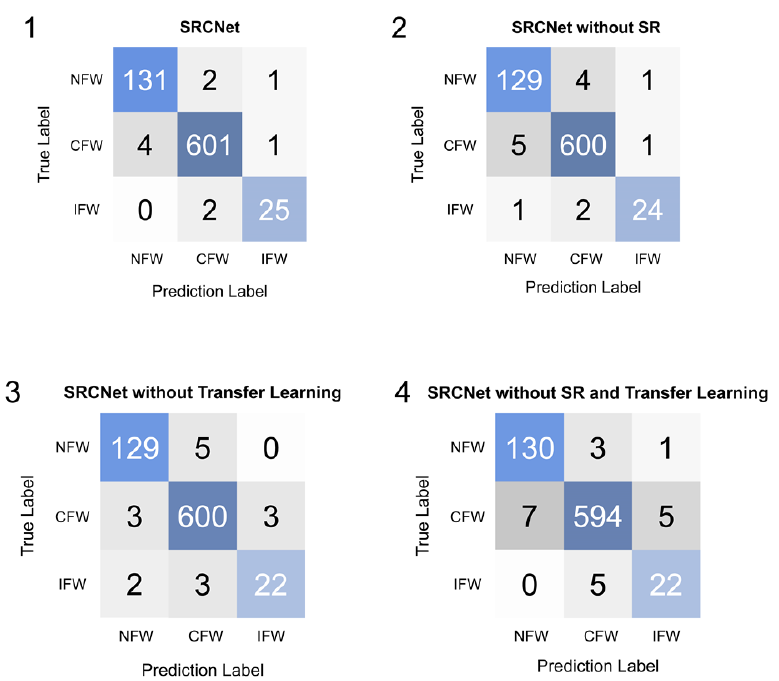
Figure 6. Comparison in confusion matrix. NFW = no facemask-wearing, IFW = incorrect facemask-wearing, CFW = correct facemask-wearing. 1 : Proposed SRCNet. 2 : Proposed SRCNet without SR